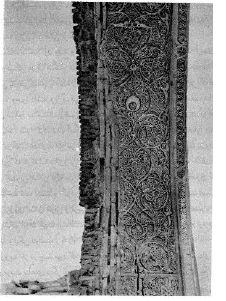
Figure 13- Robat-e Sharaf, Andre Godard, 1992